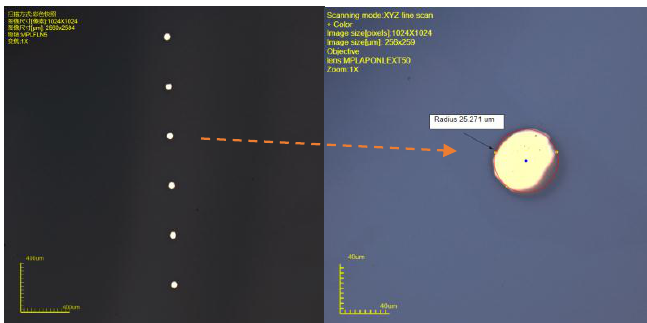
Figure 8. 3D scanning picture of metal